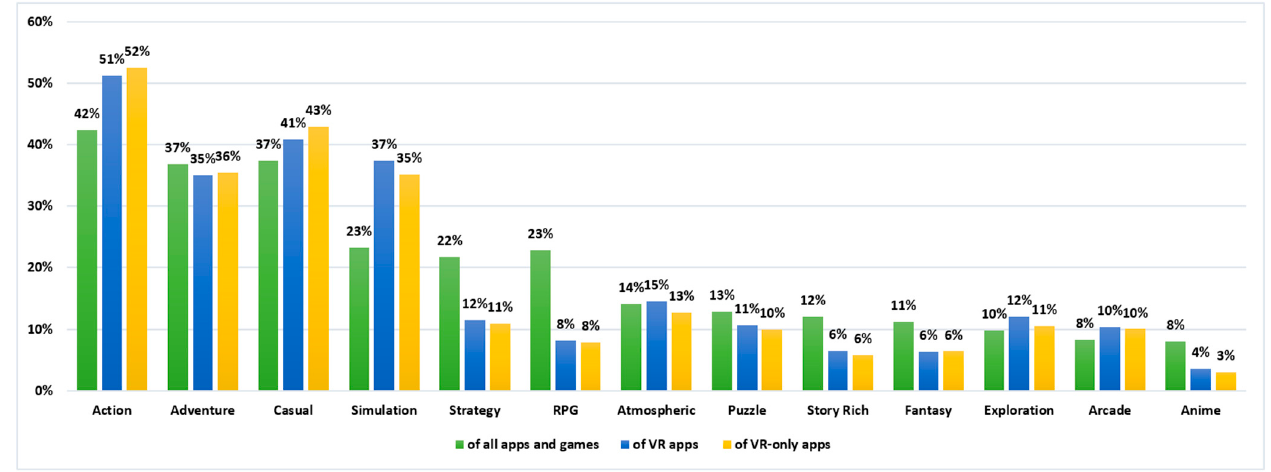
Figure 2. Percent of applications and games based in the given genre on Steam (author’s own study based on data from [35]).